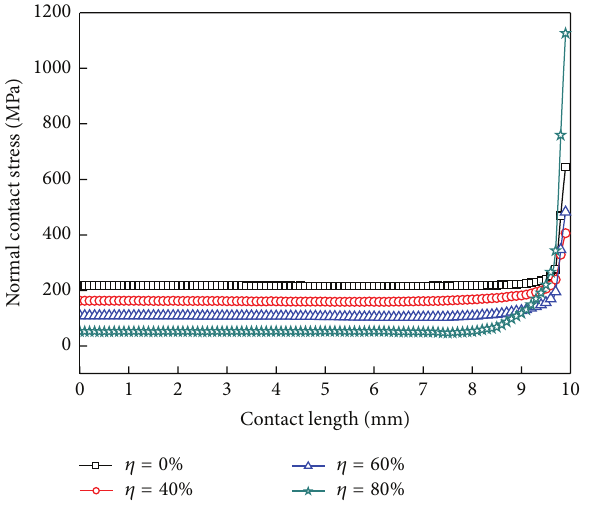
Figure 9: The stress distribution along the contact